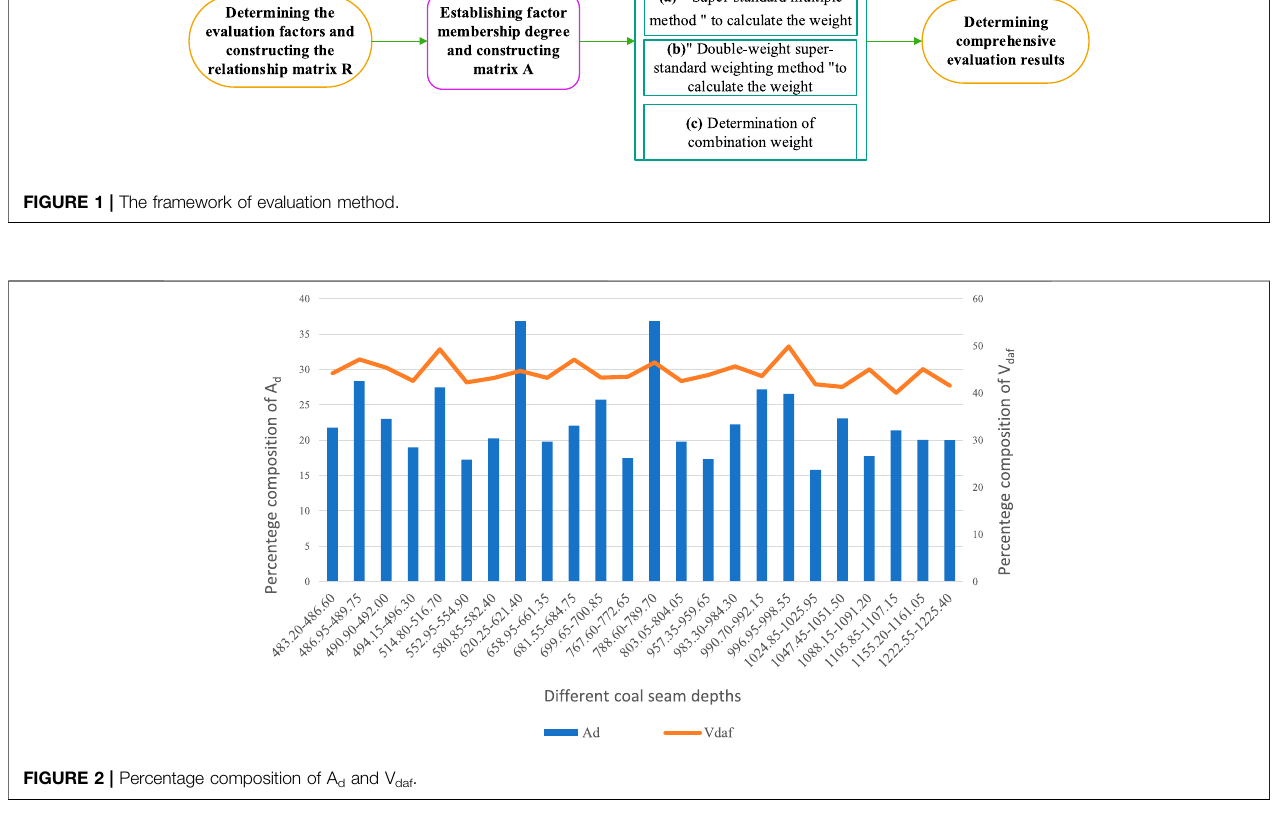
FIGURE 2 | Percentage composition of A d and V daf .